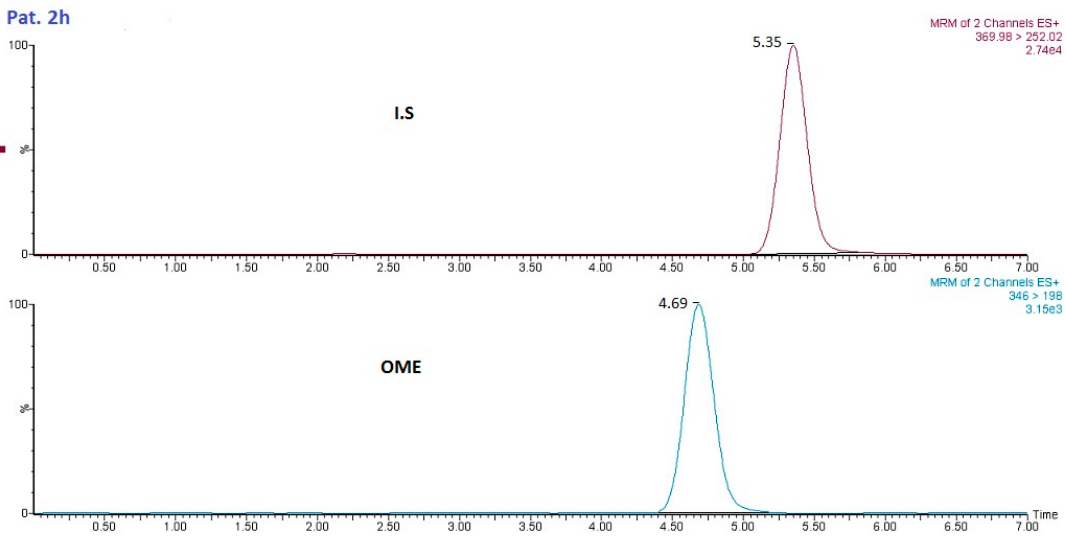
Figure 7. Chromatogram of OME from a patient sample (2 h after administration).